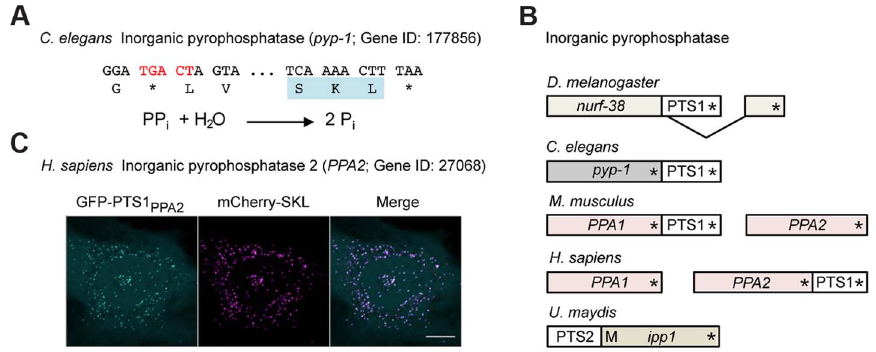
Figure 6. Inorganic pyrophosphatase is targeted to peroxisomes in different species by various mechanisms. (A) 3 9 sequence of the C. elegans pyp-1 gene encoding inorganic pyrophosphatase (Gene ID: 177856) and its translation. The readthrough element and the PTS1 are highlighted. The reaction catalyzed by inorganic pyrophosphatase is shown. (B) Schematic drawings illustrating different mechanisms leading to peroxisomal isoforms of inorganic pyrophosphatase in a variety of species. Asterisks mark the positions of stop codons. M represents an alternative methionine start codon. (C) The readthrough derived PTS1 motif of human PPA2 was fused to GFP and analyzed for peroxisomal localization in HeLa cells. Scale bar represents 10 m